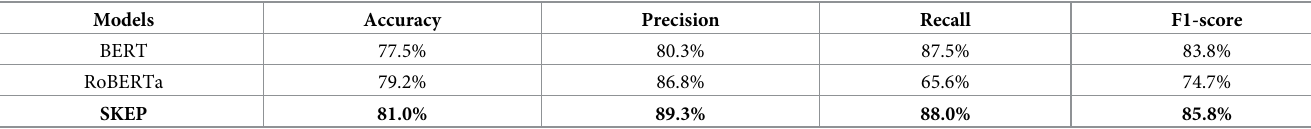
Table 1. Performance comparison of the sentiment classification